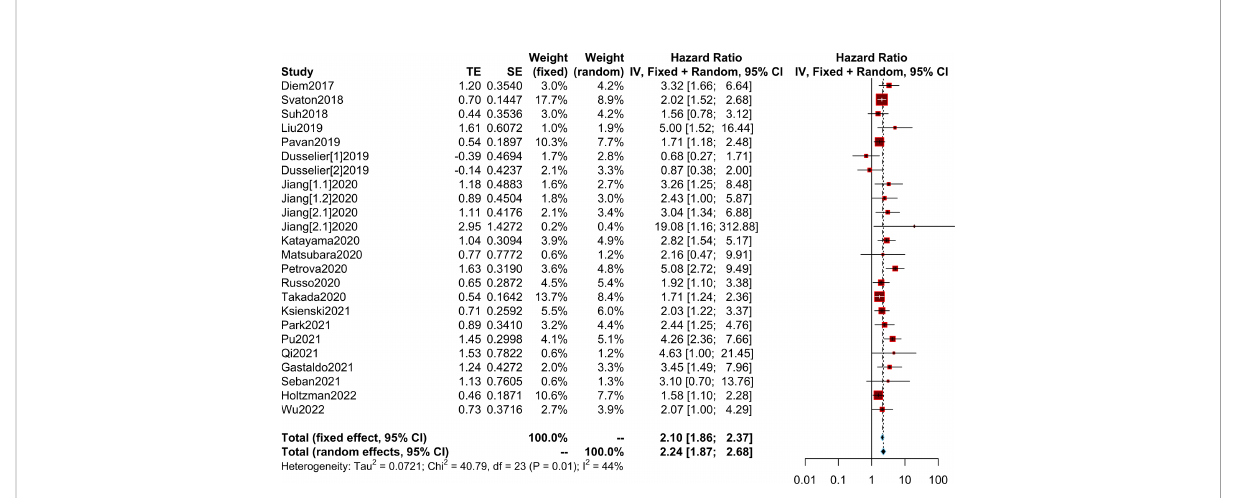
FIGURE 3 Meta-analysis of the relationship between different comparative models of the platelet to lymphocyte ratio (PLR) and overall survival